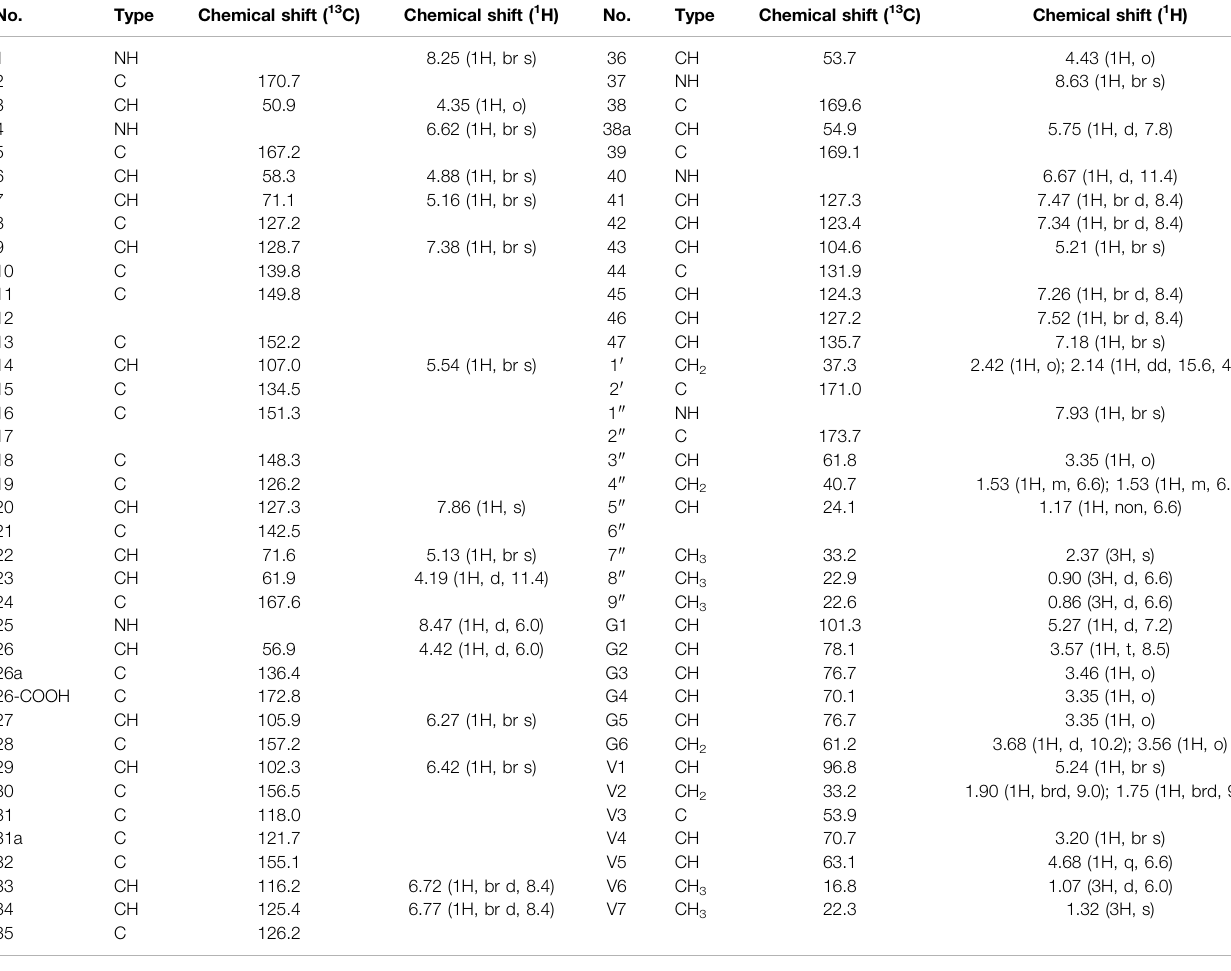
TABLE 1 | 13 C-NMR and 1 H-HMBC data of 1. No.